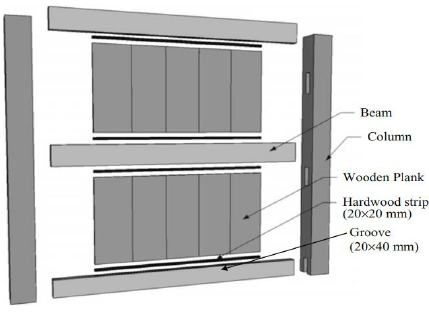
Figure 11. The structural system of Taiwanese wooden shear walls and the proposed reinforcement method